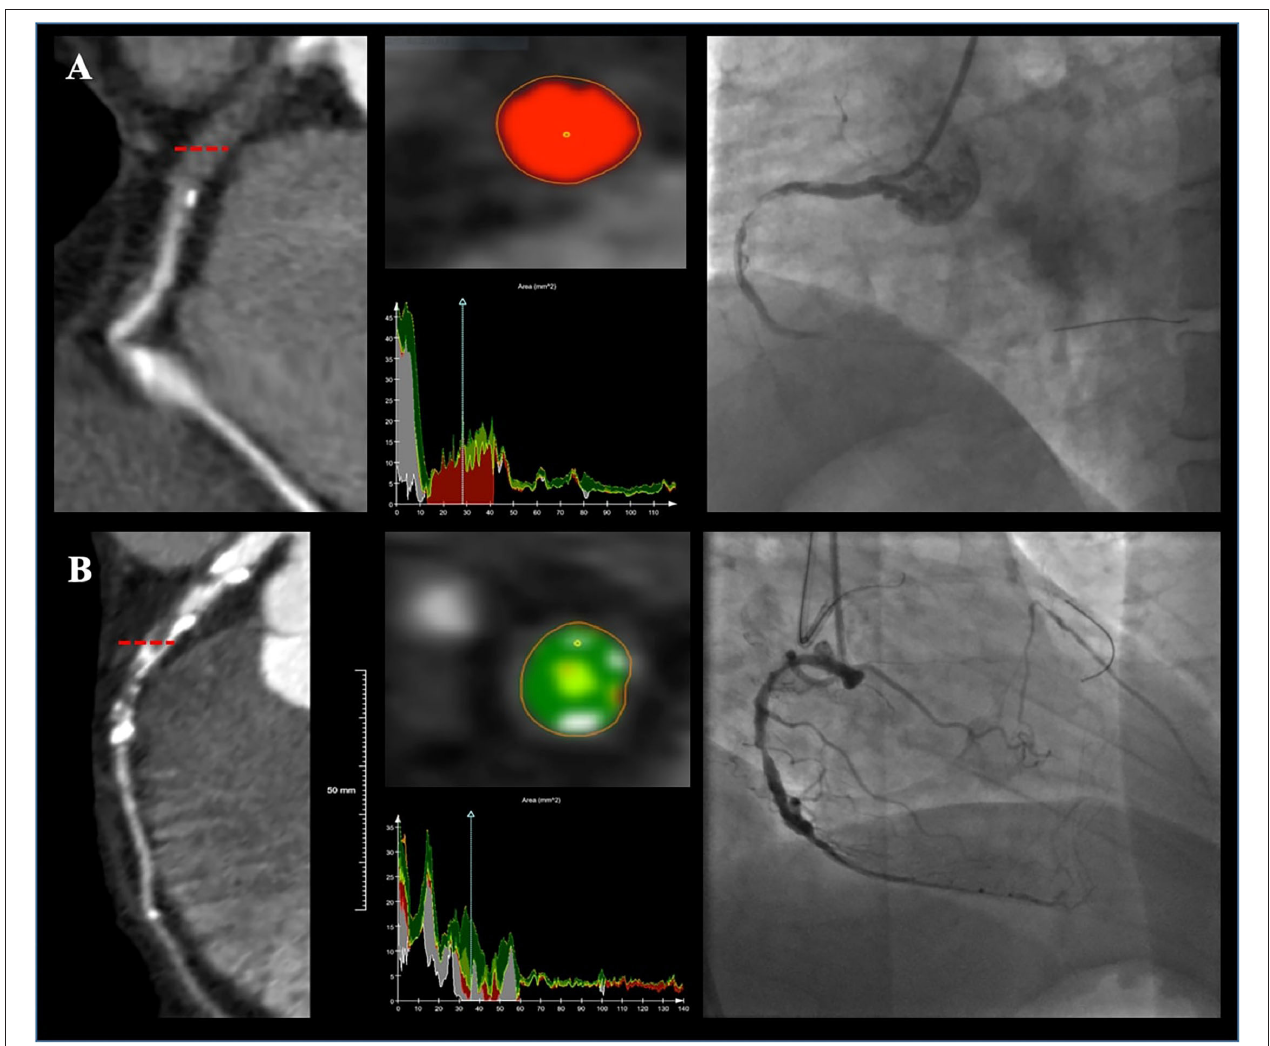
FIGURE 3 | Two representative cases showing plaque compositions and guidewire (GW) crossing outcomes. Lesion (A) was a right coronary artery (RCA) lesion with soft CTO (80.7% necrotic core, 17.4% fibrous fatty, 1.6% fibrous, and 0% dense calcium) and the GW was successfully passed at 20min. Lesion (B) was a left anterior descending artery (LAD) lesion with hard CTO (46.4% fibrous, 21.9% dense calcium, 17.8% fibrous fatty, and 13.5% necrotic core) and the GW was failed to be advanced cross the CTO.